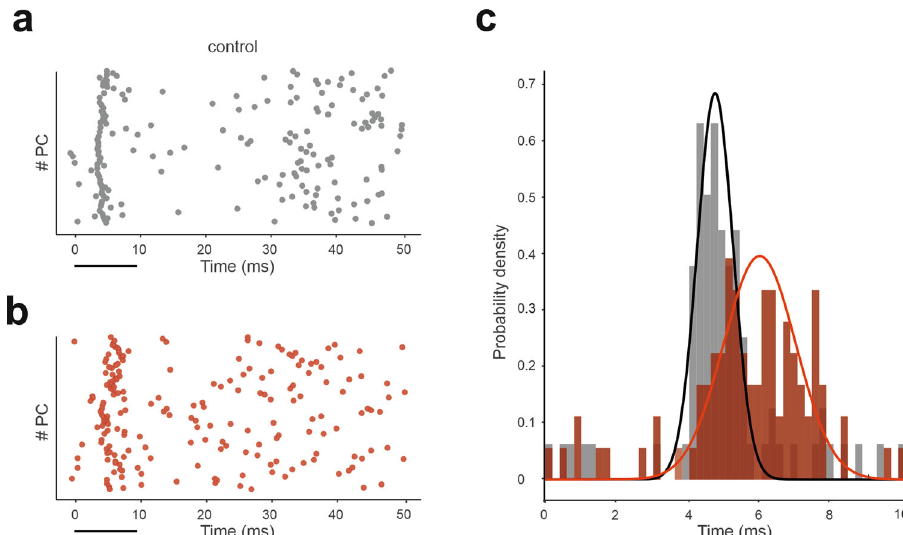
Fig. 7 Molecular layer interneurons modulate PC discharge. Raster plots of PC spikes following an impulse on a bundle of 13 mfs (time 0) in ( a ) control condition and in ( b ) KO condition, in which GABA A receptors are blocked from PC s to uncover the neural correlates of dysfunctional VOR adaptation in the PC- Δγ 2 KO mouse line ( c ) Probability density functions of spike count (time bins of 0.2 ms) in the 10-ms window following stimulation in the two conditions. Note the more scattered fi ring response in KO